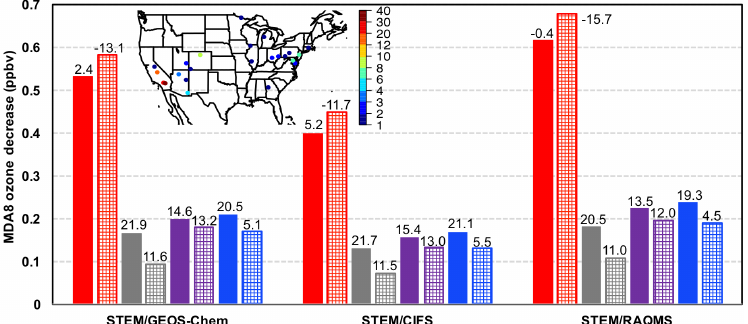
Figure 11. STEM R (MDA8, EAS, 20%) for May–June 2010 at the CASTNET sites in four US subregions (same definition as in the Fig. 10 inset), averaged on all days (bars with solid fill) and only on the days when the observed MDA8 O 3 concentrations were over 70ppbv (bars with grid pattern fill). The results from the STEM runs using GEOS-Chem, ECMWF C-IFS, and RAQMS boundary conditions are shown separately. Biases for the corresponding model base runs are shown above the bar plots. Inset shows the number of days when the observed MDA8 O 3 concentrations were over 70ppbv at various CASTNET